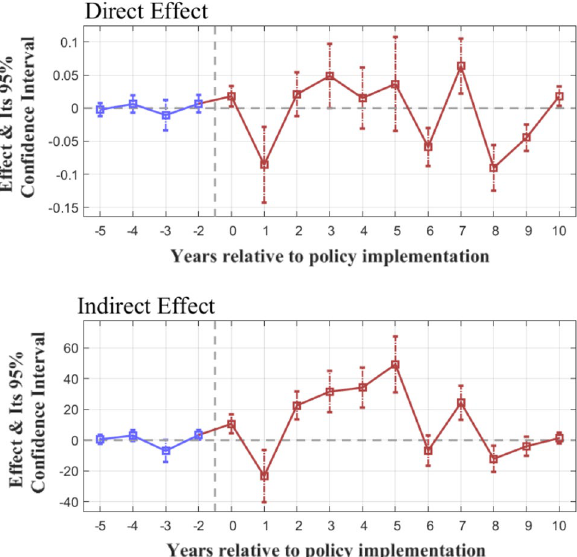
Figure 2. Parallel trend test